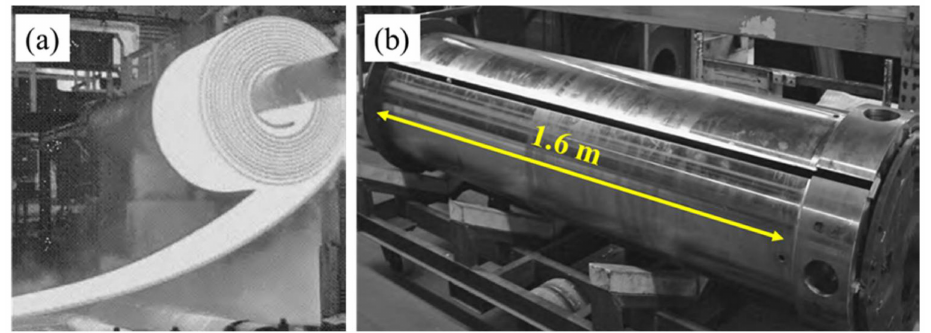
Figure 12. ( a ) Hot steel coil being wound, showing the harsh conditions of steel manufacturing. ( b ) Image of a wrapper roll. Adapted with permission from [7]. 2013, ASM